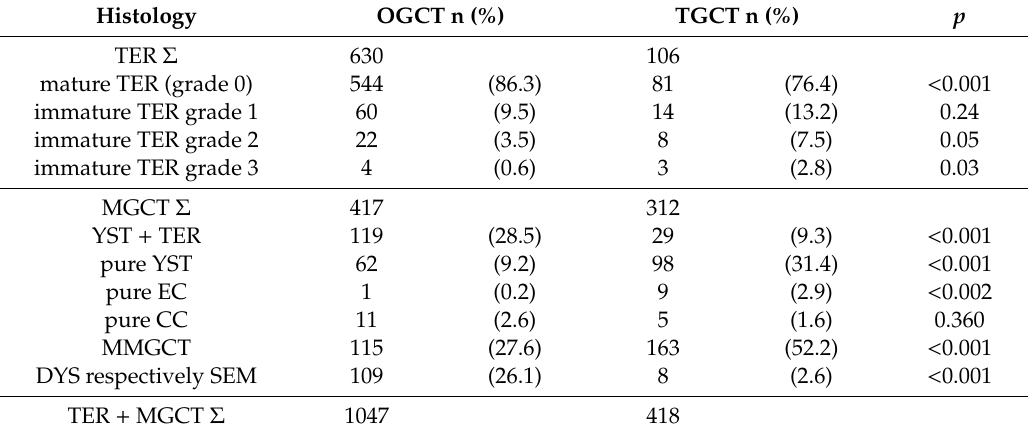
Table 3. Histologic subentities of the patients aged 0 to < 18 years. TER: teratomas, YST: yolk sac